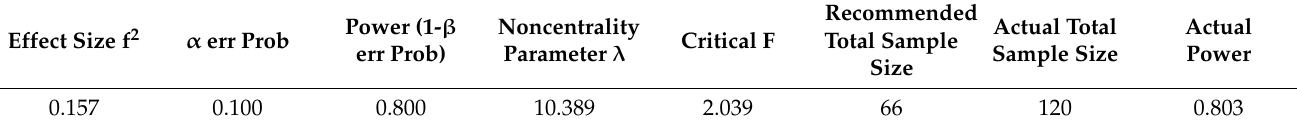
Table 10. Statistical power of mediation analysis sample size.